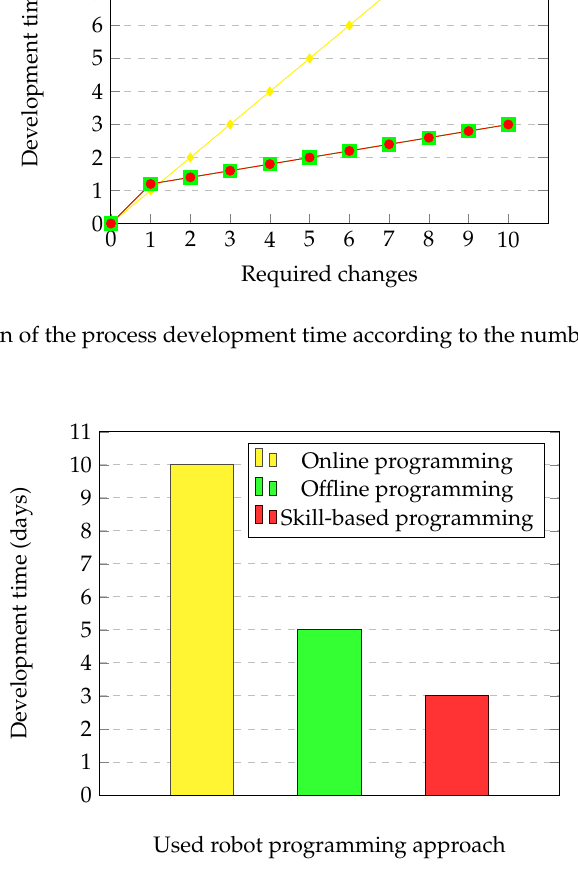
Figure 16. Comparison of the process development time when the robot provider is